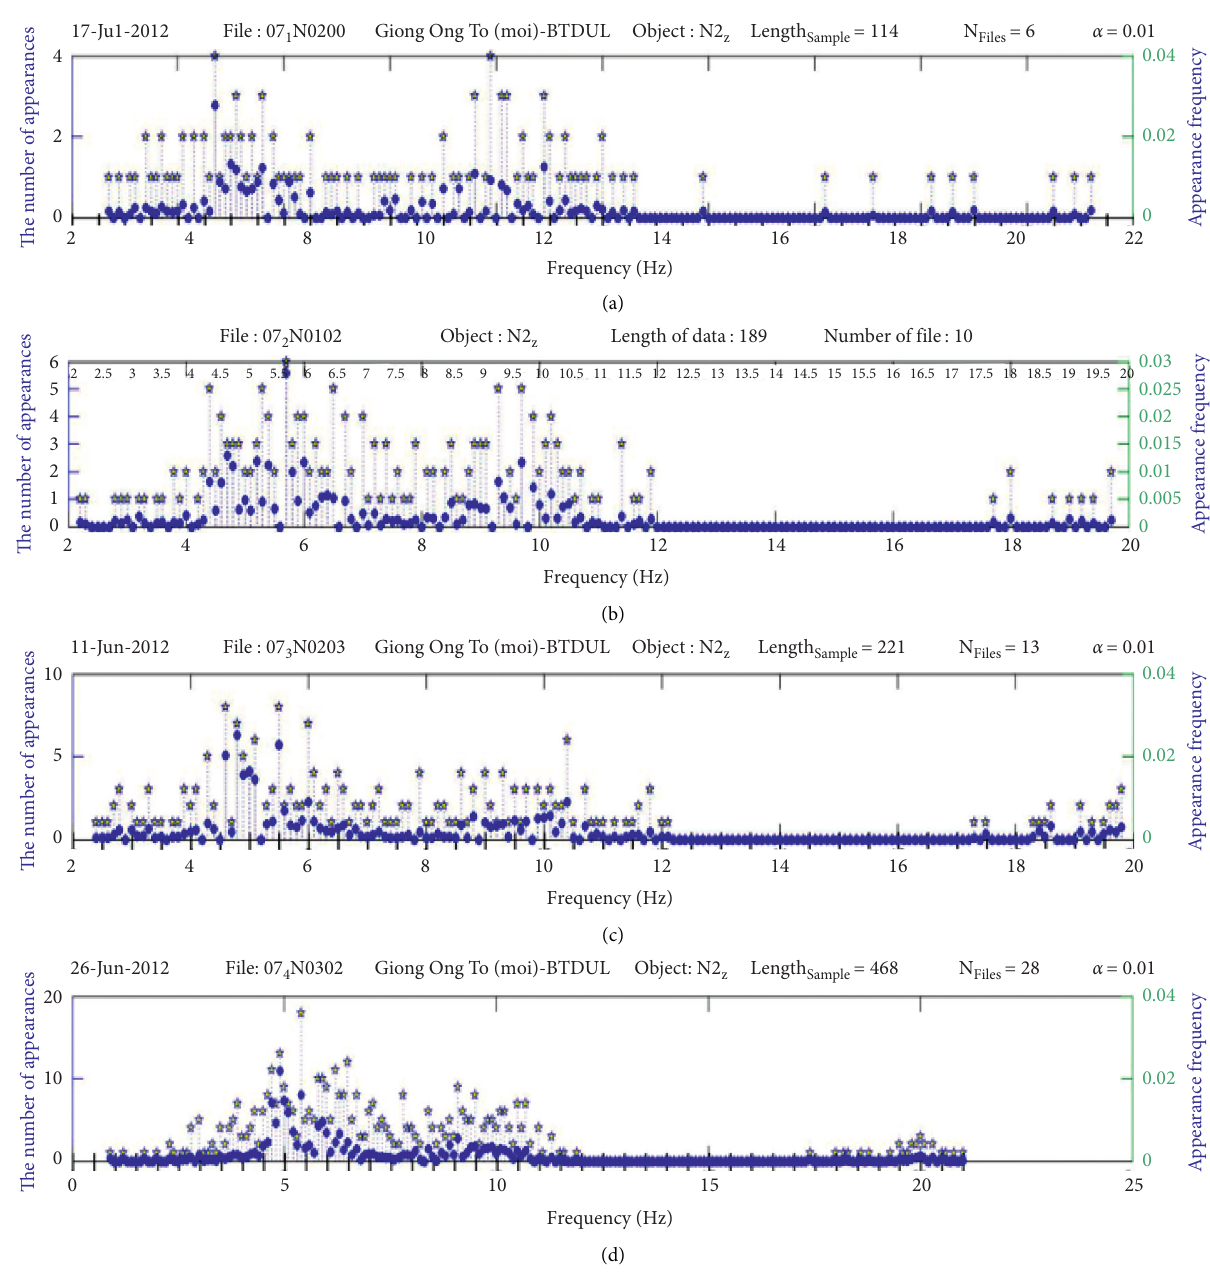
Figure 17: A representative power spectral density of Giong Ong To Moi bridge. (a) The first time (July 19, 2011). (b) The second time (December 22, 2011). (c) The third time (June 11, 2012). (d) Fourth time (July 11,